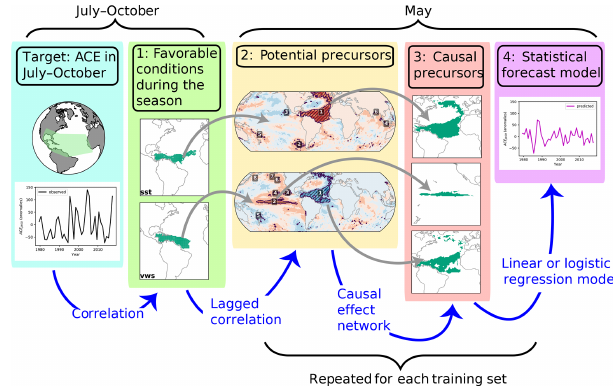
Figure 1. Schematic overview of the four steps to build a forecast model for ACE in July–October (left): (1) the regions of interest for two favourable conditions of hurricane activity (SST and VWS) are identified. (2) For each of the favourable conditions of (1) potential precursors in May are identified by clustering the most significantly correlated grid cells within SST data. (3) Causal effect networks are used to select a sub-set of robust precursors. (4) A statistical model is built based on the identified robust precursors of (3). Steps (2)– (4) are repeated for the different training sets, leading to a different forecast model for each hindcasted